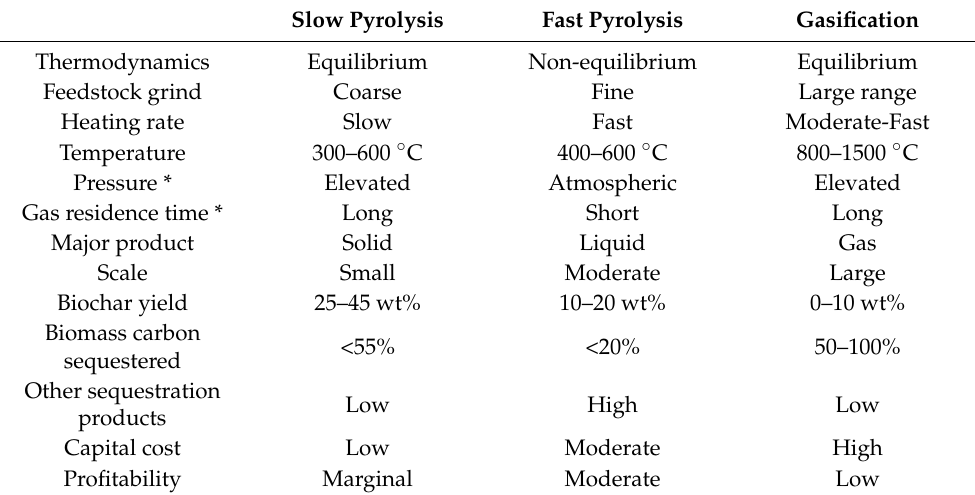
Table 1. Characteristics of thermochemical processes for use in carbon negative energy. Slow Pyrolysis Fast